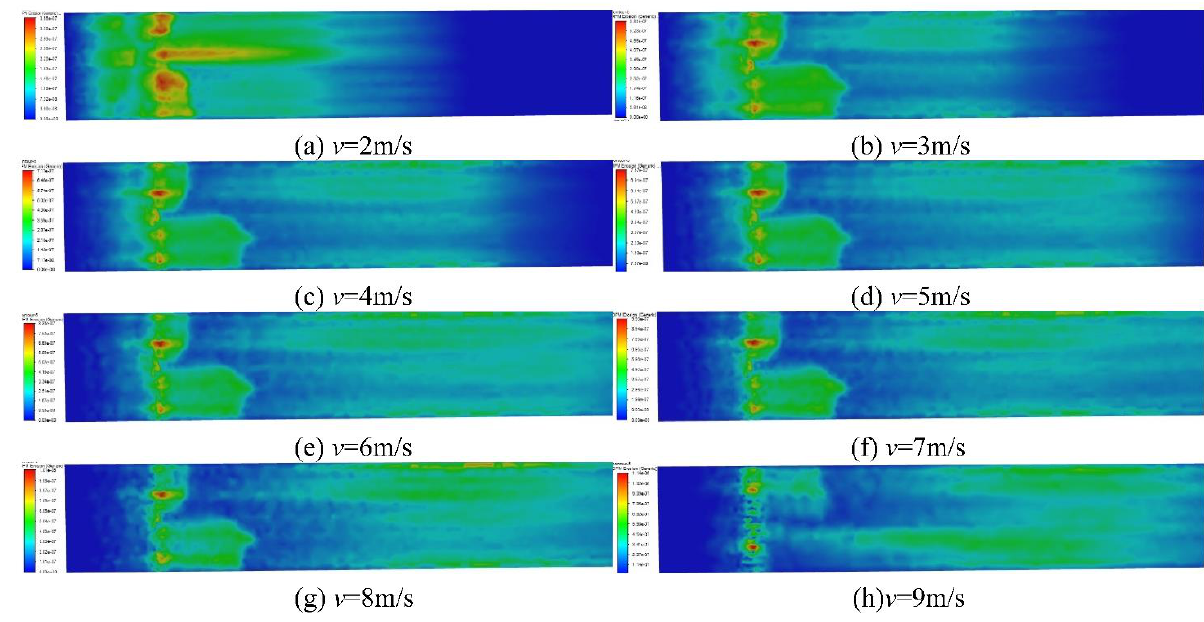
Figure 11. Erosion cloud diagram of spillway bottom at different flow rates. The maximum erosion amount corresponding to different inlet flow velocities is shown in Figure 12. In general, the erosion amount increases with the increase in flow velocity, but the growth trend is more complex. For the bottom of the spillway, the erosion increment decreases with the increase in the flow velocity. When the velocity is greater than 7 m/s, the erosion increment does not increase much and tends to be stable. For the gate, the erosion increases exponentially with the increase in flow velocity.